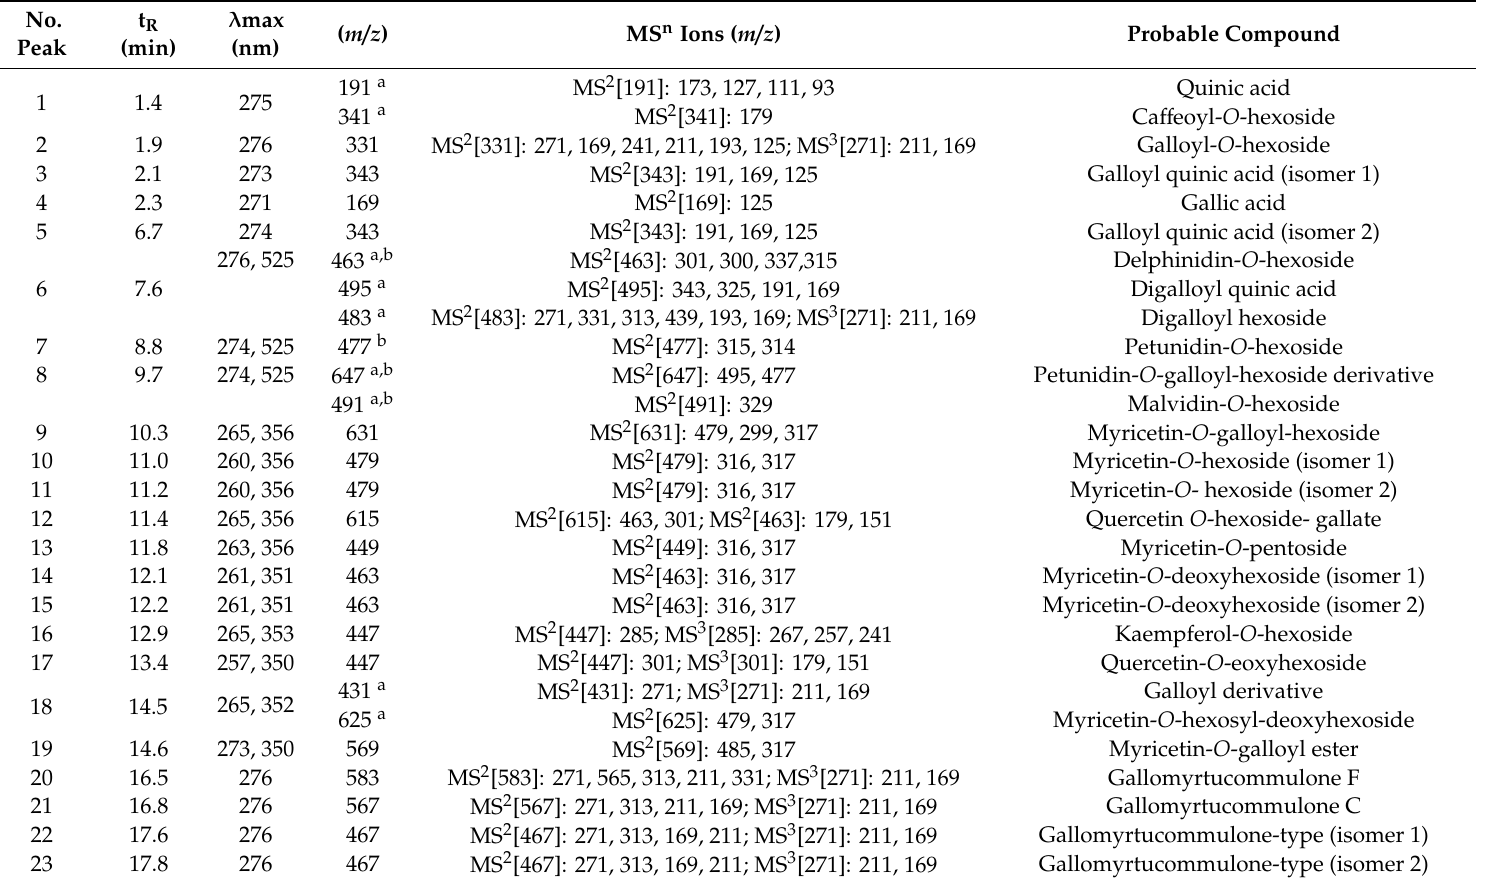
Table 4. UHPLC-DAD-ESI-MS n data for M. communis pericarp extract obtained under optimized UAE